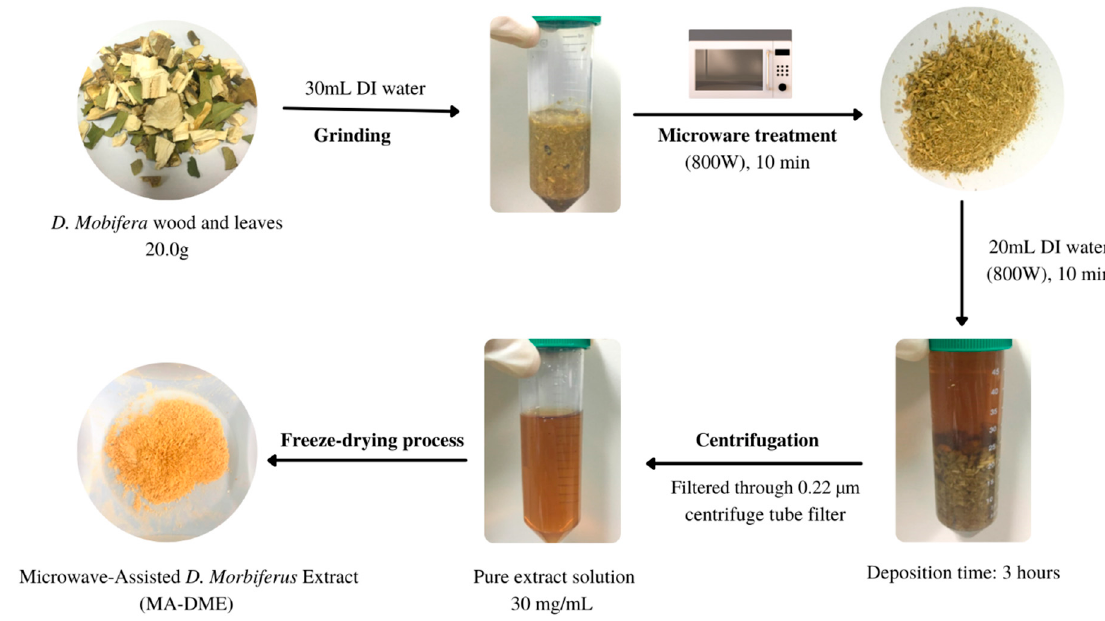
Figure 1. The extraction process for MA-DME.